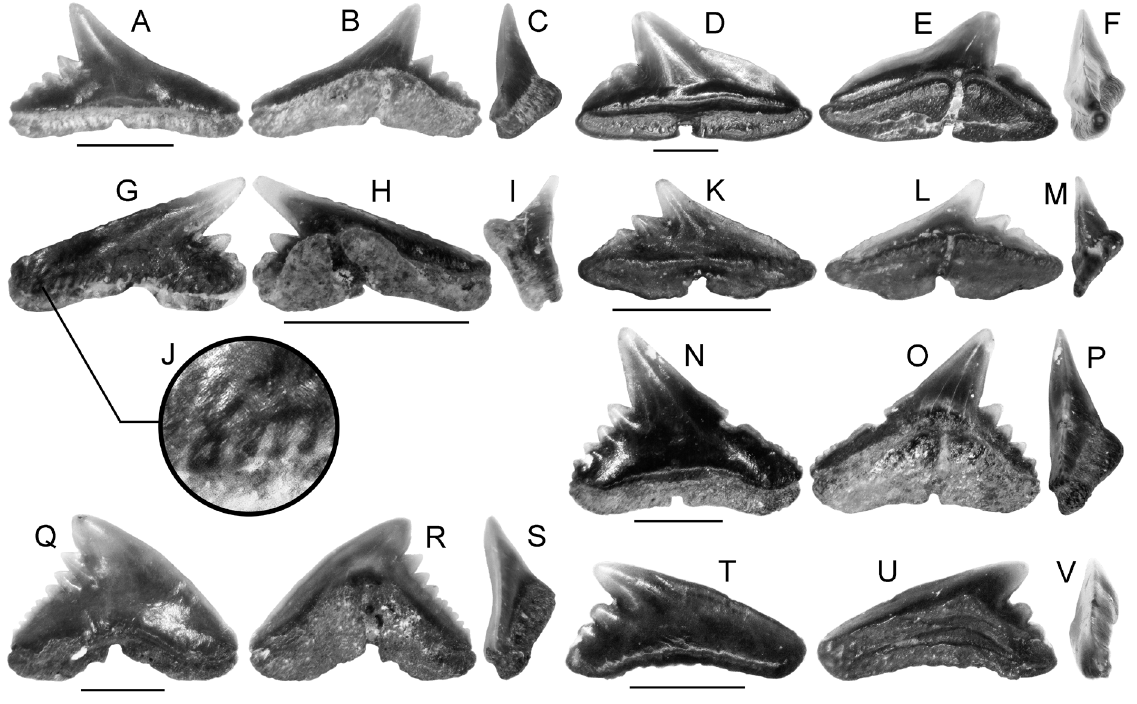
Fig. 23. Galeorhinus de Blainville, 1816 and Pachygaleus Cappetta, 1992, teeth. A–F . Galeorhinus